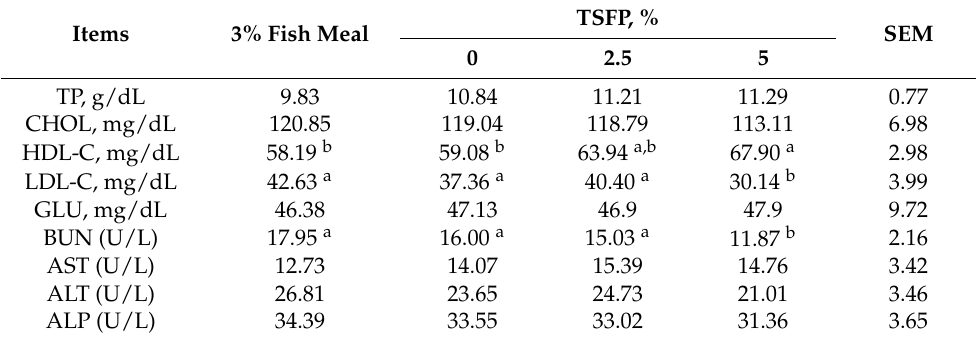
Table 6. Effect of TSFP on blood biochemistry of finishing pigs.